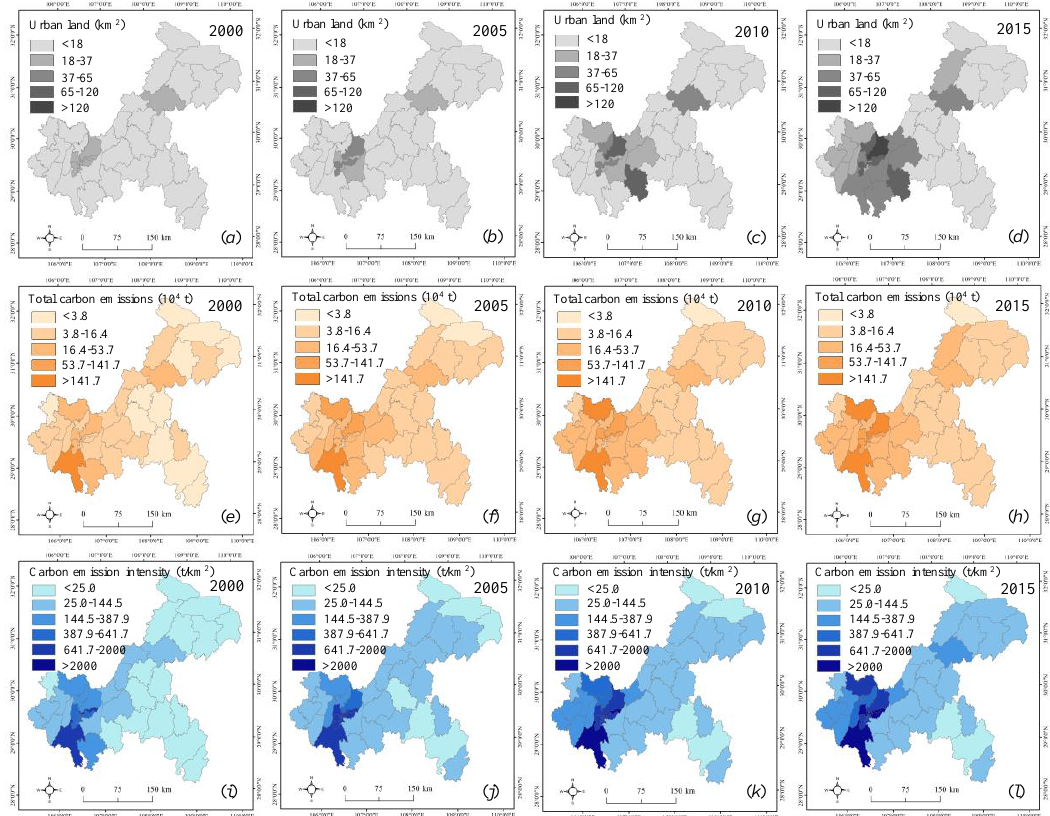
Figure 5. Spatiotemporal variations of urban land and carbon emissions at the county scale in Chongqing from 2000 to 2015. Note: ( a )–( d ) urban land; ( e )–( h ) total carbon emissions; ( i )–( l ) carbon emission intensity. Table 1. The shift distance between urban land and carbon emissions at different scales. Scale Variable